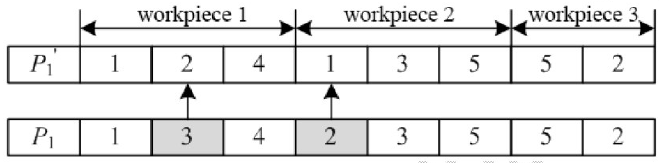
Figure 6. Mutation operation based on machine